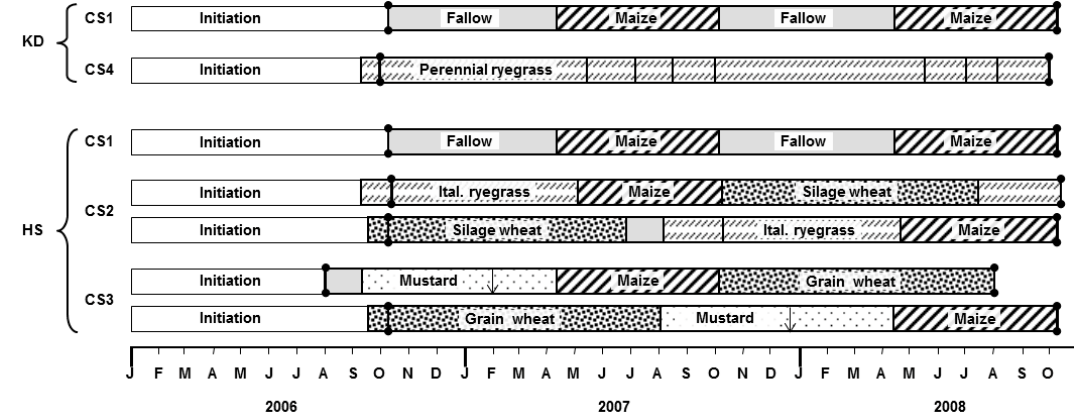
Figure 1. Cropping systems of the field trial in Hohenschulen (HS) and Karkendamm (KD). Thin vertical lines indicate sowing or harvest cutting dates respectively. If the interval between harvesting and sowing of the following crop was <14 days, sowing date was not additionally shown. Arrows indicate the freezing-off date of the catch crop, used as the harvest date. Thick vertical lines with dots show start and end of the period, which was considered by quantification via modelling (24 months). ‘Initiation’ indicates the model calculation period conducted in advanced to level off some output variables, e.g., soil water contents.